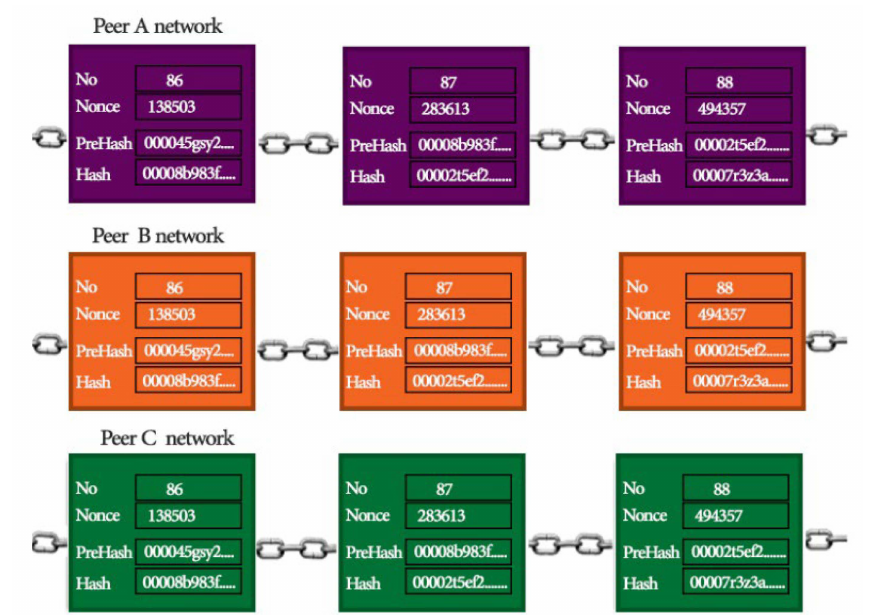
Figure 10. In normal circumstances, a blockchain connection is